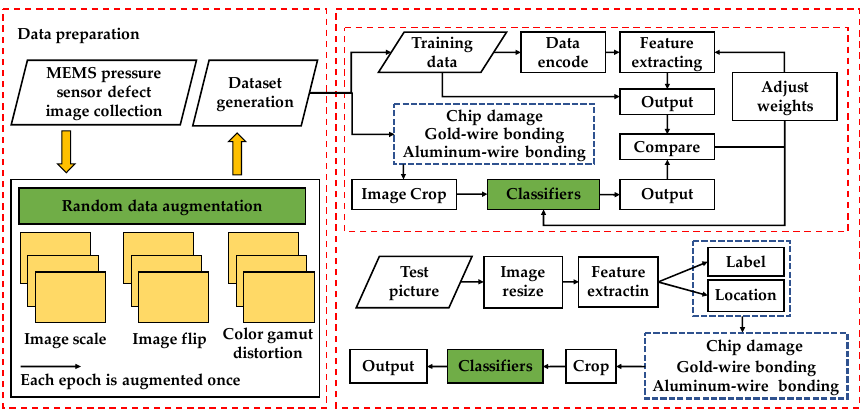
Figure 5. Workflow of the ADCNN for dealing with the defect images.